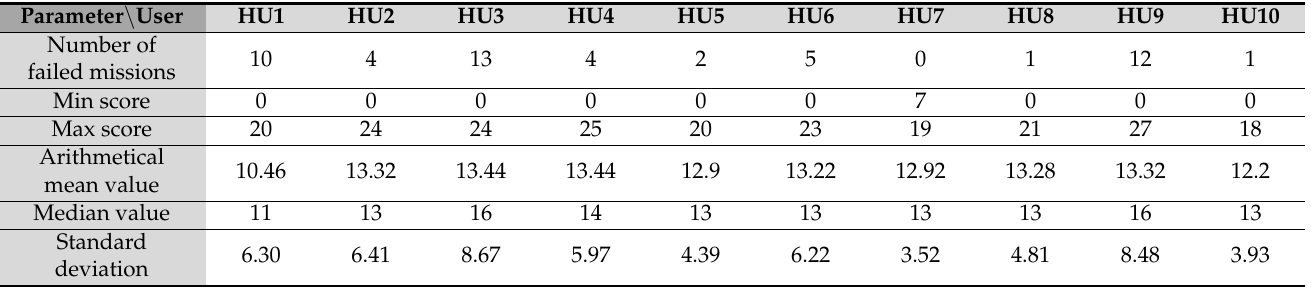
Table 3. Performance data of untrained human users in a dynamic mode environment, based on the 50 simulation cycles.